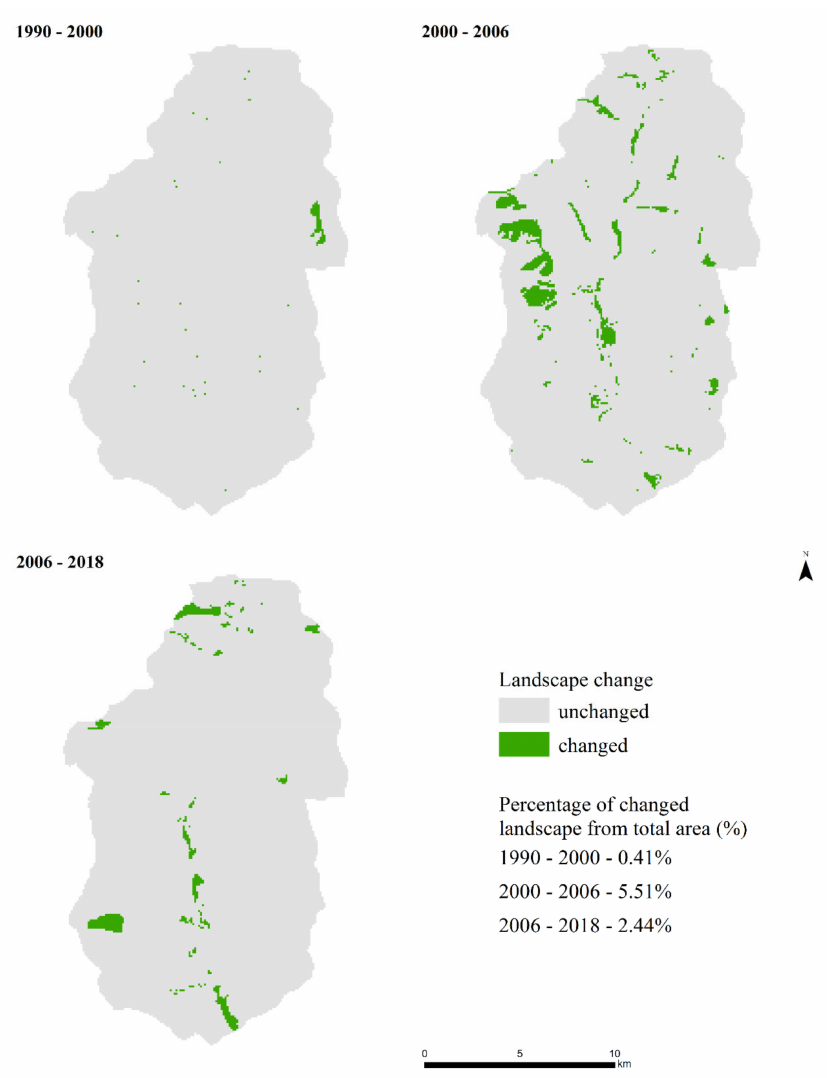
Figure 3. Landscape change map based on a Binary model developed over three time periods (1990–2000, 2000–2006,